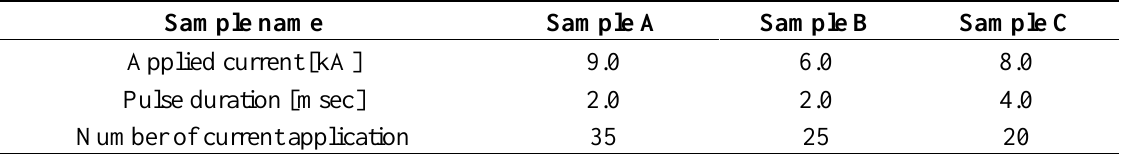
Table 2. Conditions of electric current